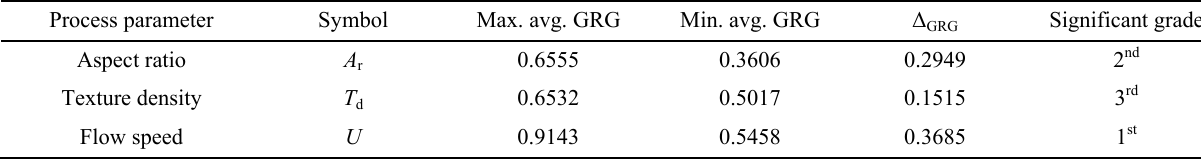
Fig. 11 Optimum (a) texture geometry and (b) pressure profile for flat bottom profile. Table 5 The most significant process parameter of flat bottom profile.